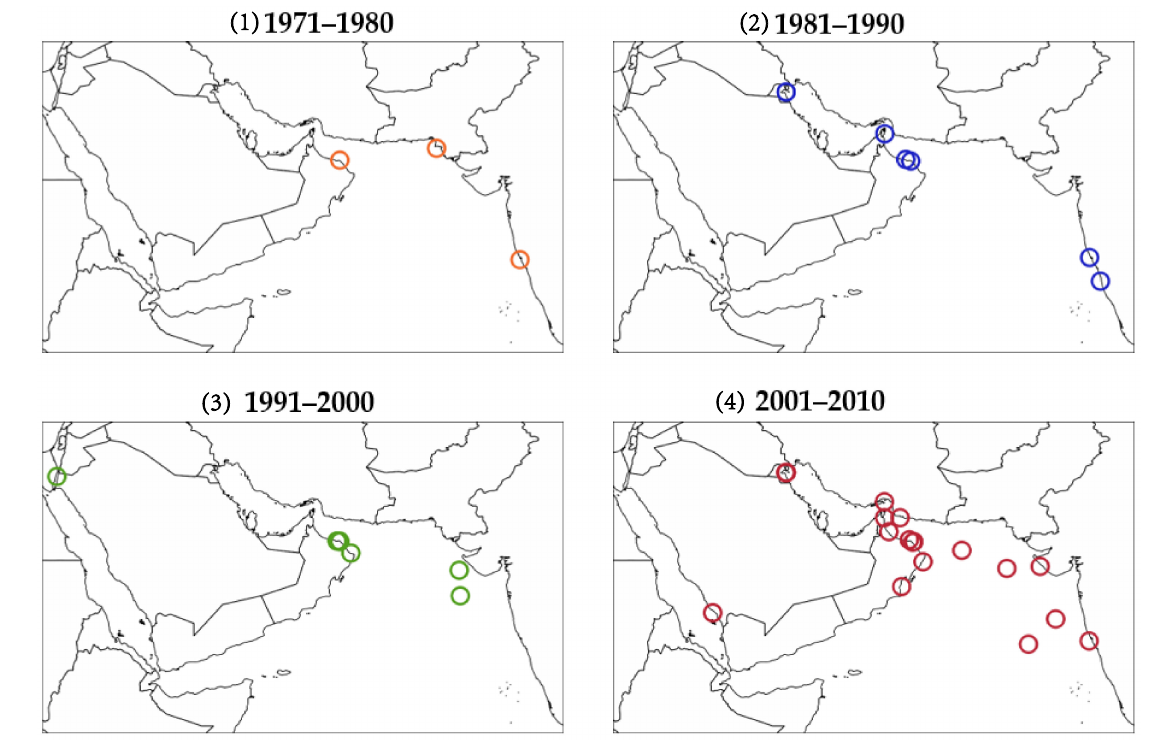
Figure A3. Algal bloom outbreaks in the NIO during December–February over four decades: ( 1 )